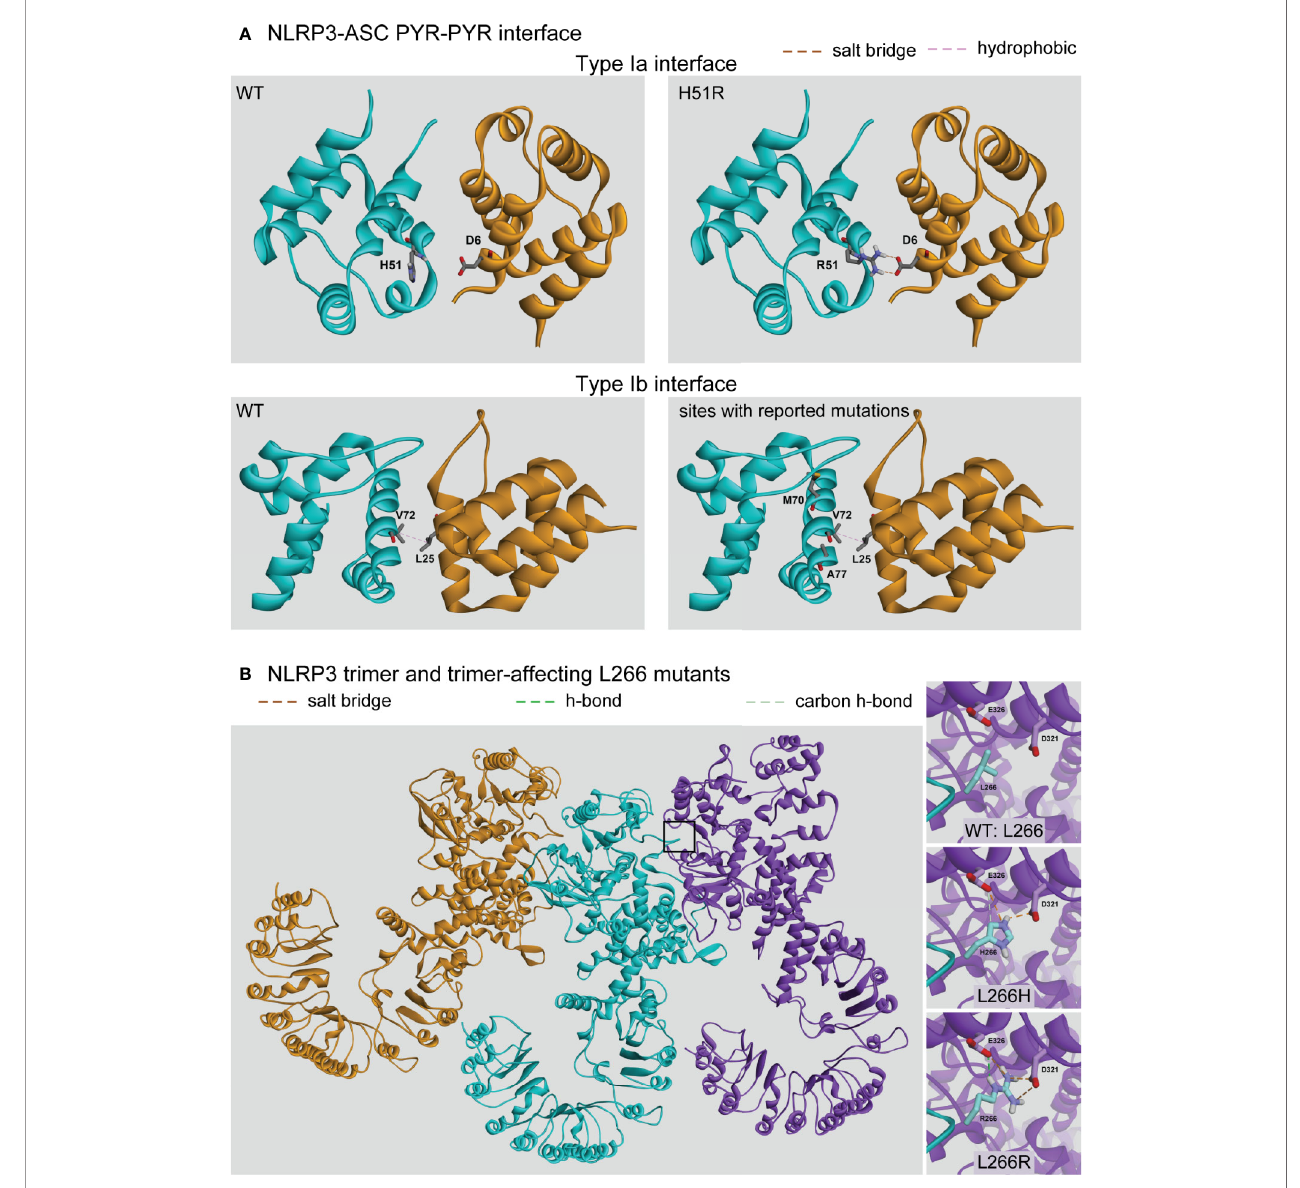
FIGURE 5 | Protein-Protein Affecting Mutations. (A) Predicted interaction between the pyrin domains of NLRP3 (cyan) and ASC (orange) at either the Type Ia or Type Ib interfaces. (B) The trimer of NLRP3 monomers (orange, cyan, and purple) with the predicted intermolecular interactions between the wild-type (WT) (Leu266) or the two identi fi ed mutations (L266H and